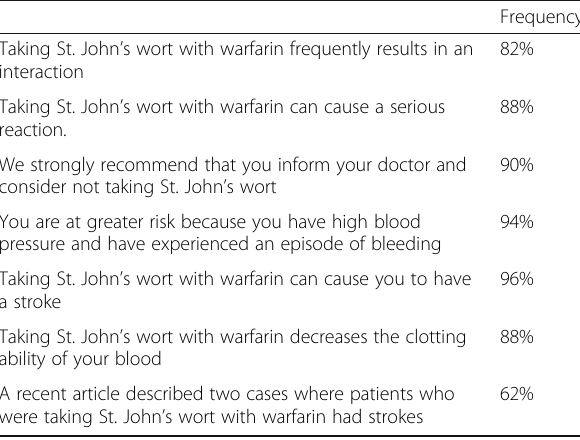
Table 6 Patient preferences regarding types of information they would like to receive ( N =